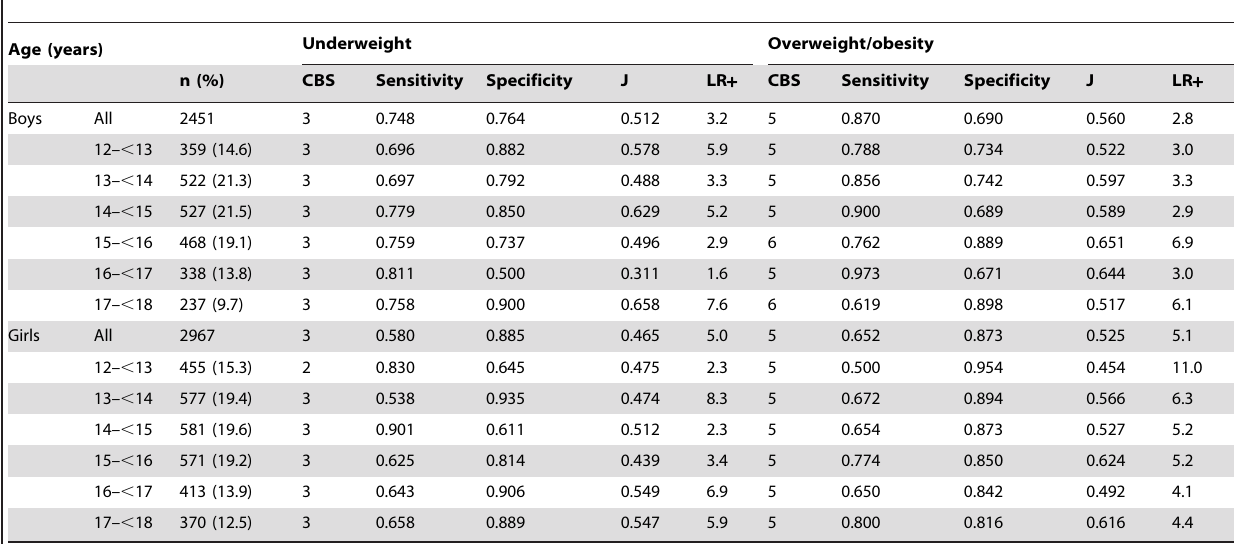
Table 2. Optimal current body size cut-offs for overweight/obesity and underweight by sex and age.